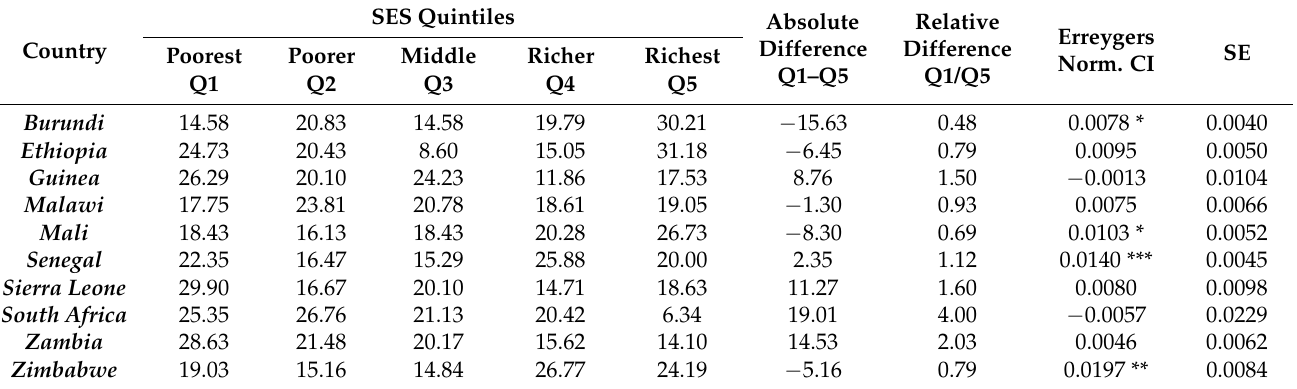
Table 6. Estimated prevalence of overweight among children by socio-economic status (SES)